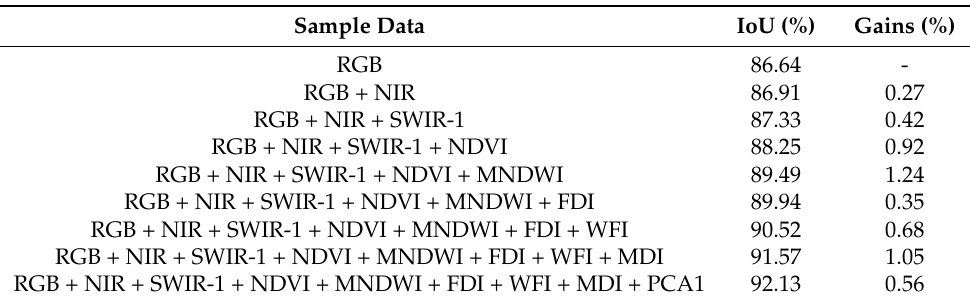
Table 5. Effect of original band and multispectral index to the classification result of mangrove under the ResNet-based FCN structure.